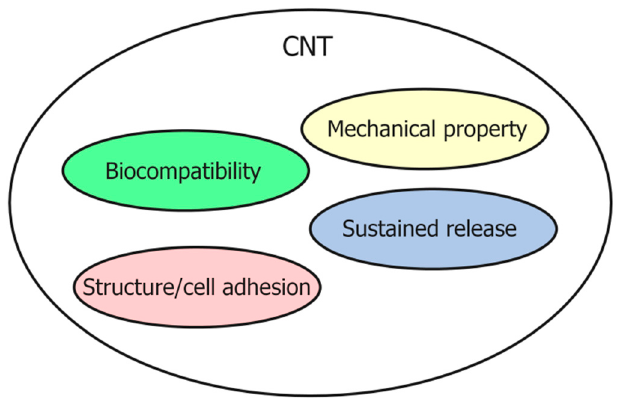
Figure 6. Characteristics of CNT scaffolds. The material properties of CNTs are suitable for bone regeneration scaffolds due to their biocompatibility, structure, mechanical properties, and ability to provide sustained release.